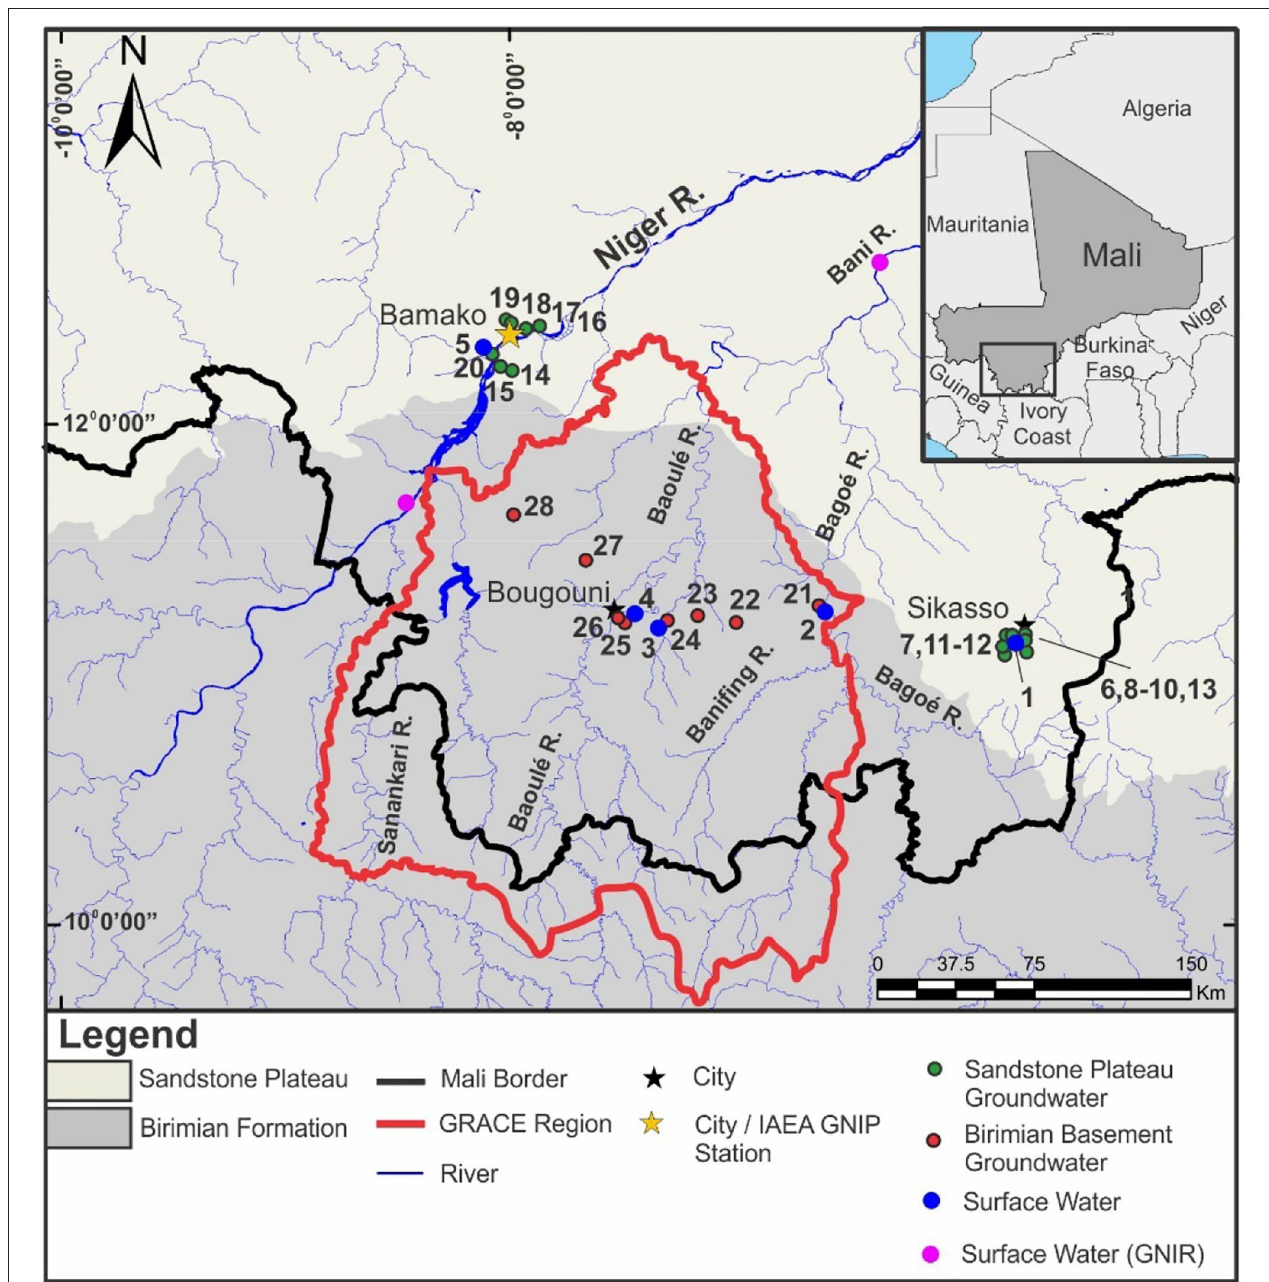
FIGURE 4 | Location of groundwater samples in the Birimian and Sandstone Plateau and surface water samples collected in May 2008, and surface water samples from the Global Network of Isotopes in Precipitation (GNIP) for the Niger and Bani